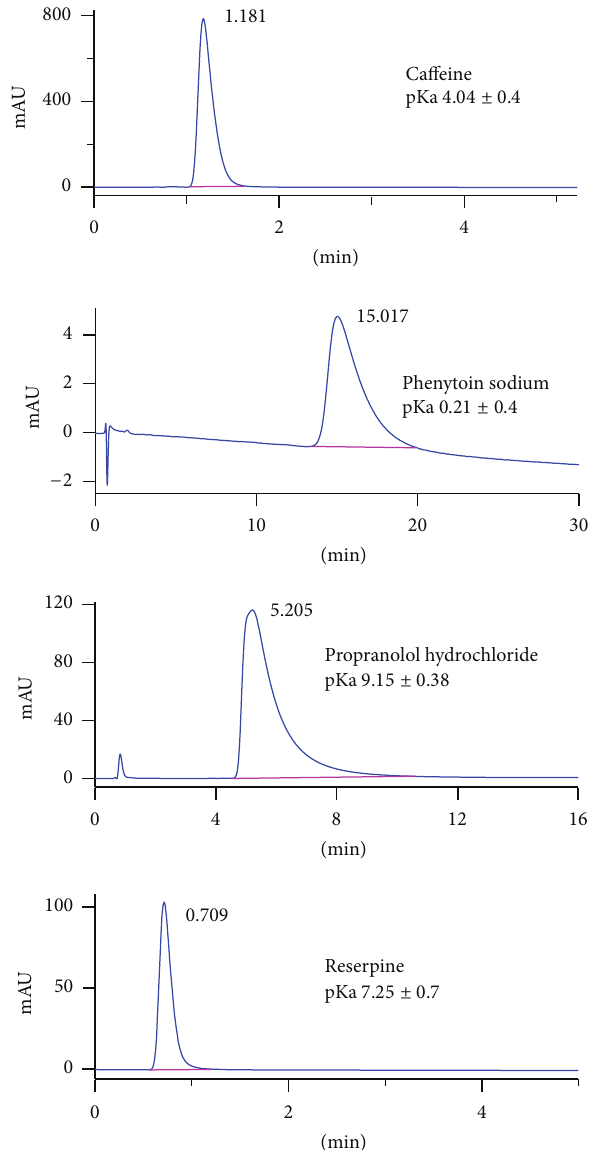
Figure 4: Correlation between reciprocal values of retention time of reference compounds (pKa < 7.0) by immobilized HAS-HPLC and the reported PPB values. The solid line was linear ship achieved by Origin 6.0 linear regression fit. The dash line represents 95% prediction